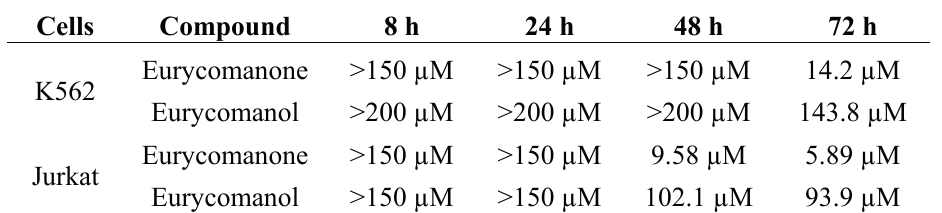
Table 2. The effect of eurycomanone and eurycomanol on K562 and Jurkat cell proliferation. IC 50 values were determined using Prism 6.0 (GraphPad), based on leukemia cell proliferation rates during 84 h by using video microscopy.